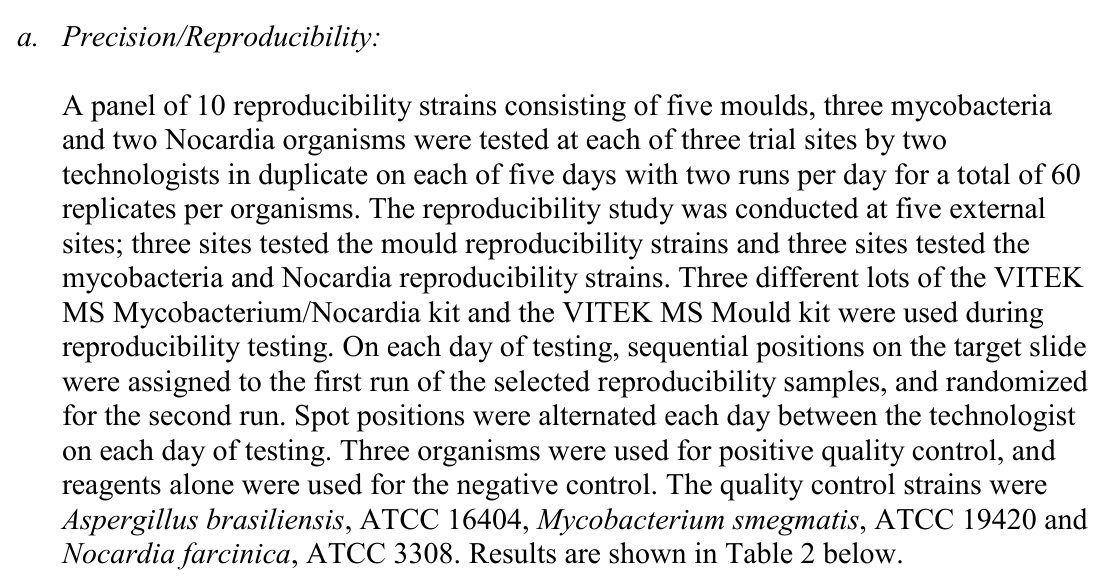
Table 2: Reproducibility Testing for Moulds, Mycobacteria and Nocardia –all sites combined